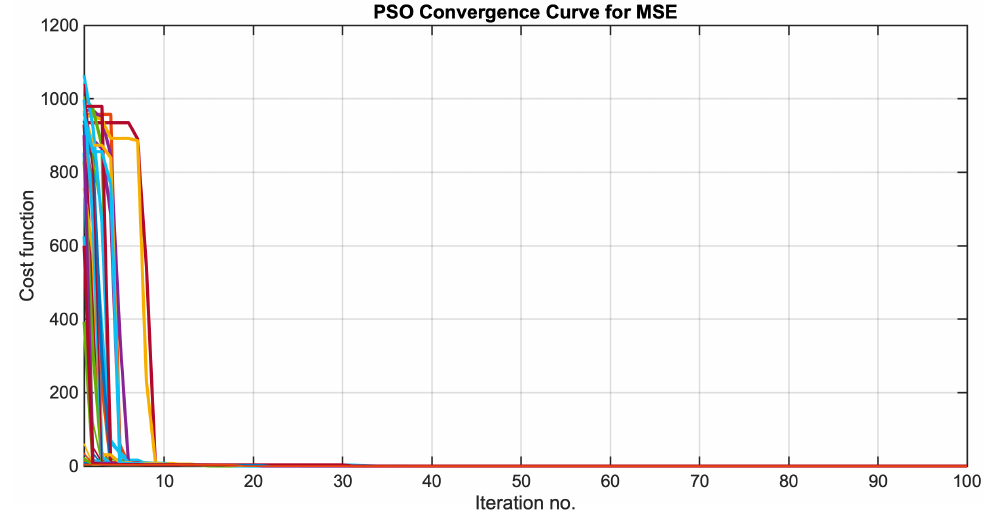
Figure 8. Convergence curves for the MSE cost function in 100 Monte Carlo